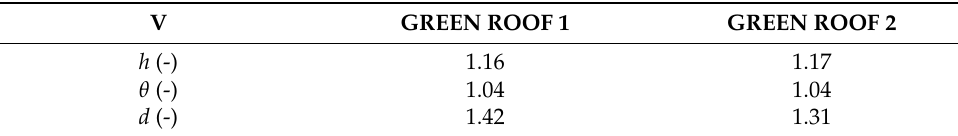
Table 2. Coefficient of variation of rainfall variables.